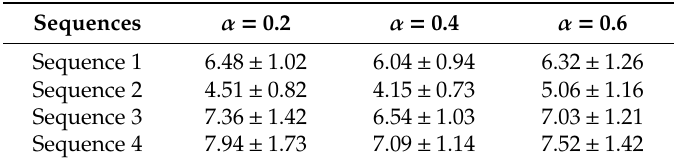
Table 2. Average 2D error according to the parameter α .